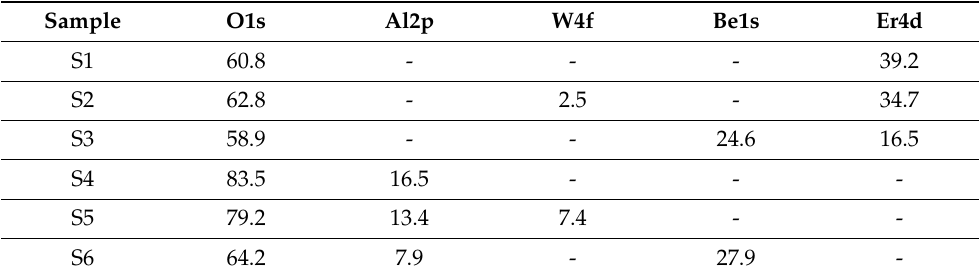
Table 3. Element relative concentrations